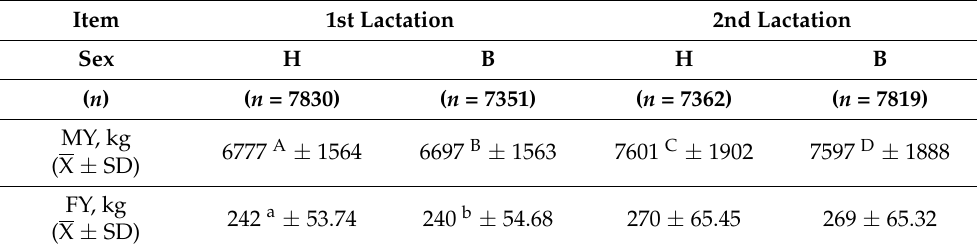
Table 3. Effect of calf sex on milk yield (X ± SD) and fat yield (X ± SD) in the first two standard lactations.